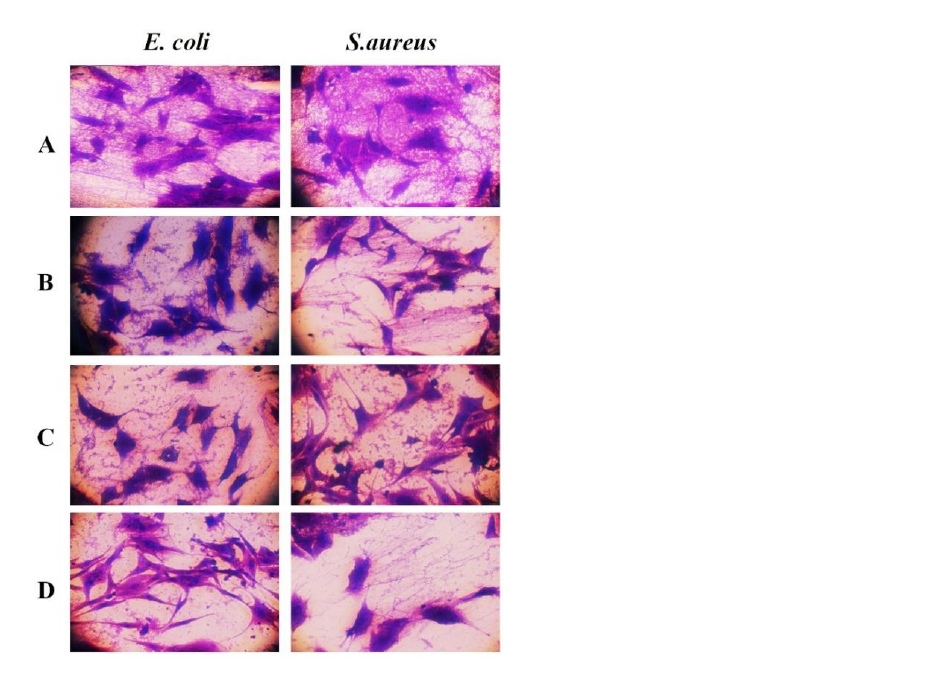
Figure 11. GONPs, GONPs–PEG and GONPs–PEG– N. sstiva inhibits invasion of bacterial strains in REF cells as indicated; ( A ): control REF cells infected with bacterial strains, ( B ): REF cells pre-treated with GONPs then infected with bacterial strains, ( C ): REF cells pre-treated with GONPs-PEG then infected with bacterial strains, ( D ): REF cells pre-treated with GONPs–PEG- N. sativa then infected with bacterial strains.